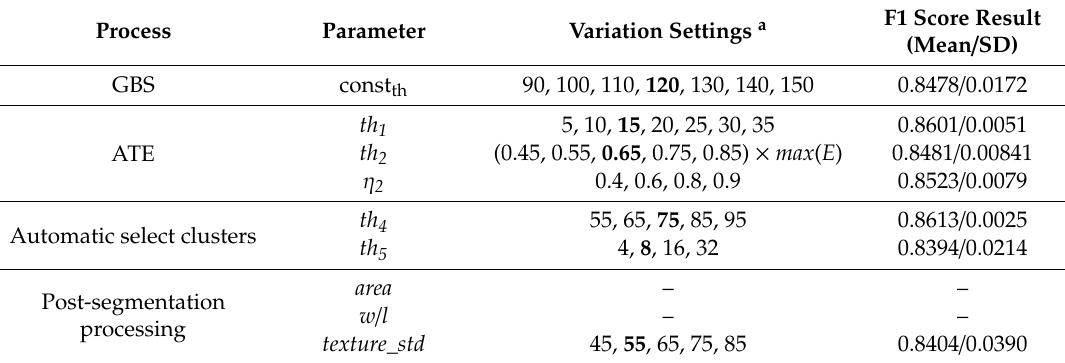
Table 2. The result of di ff erent parameters